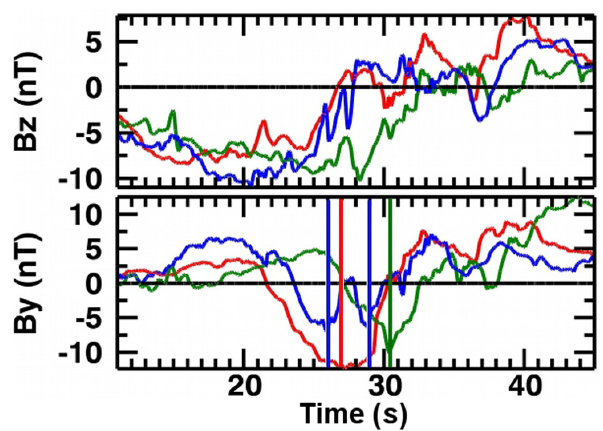
Fig. 6. An example of simultaneous single and double peak B y core field signatures. The X-axis shows seconds from 09:55:00UT on 1 October 2001. The B z bipolar signatures and the B y signature of a flux rope. SC2 red, SC3 green, SC4 blue. The vertical lines mark the B y core field